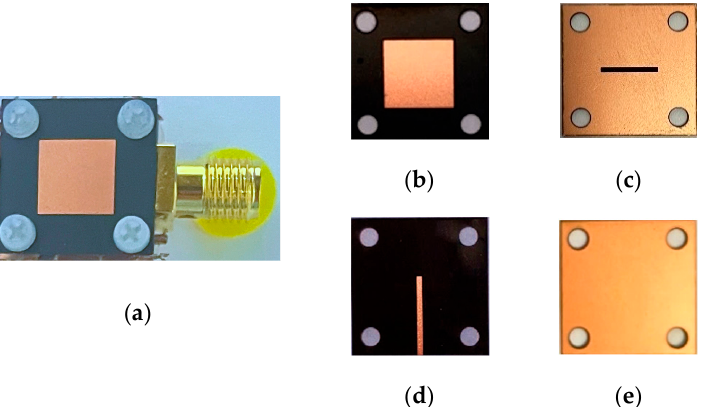
Figure 11. The photograph of the proposed antenna element: ( a ) top view, ( b ) top layer with radiation patch, ( c ) the ground with coupling aperture on top of the middle substrate layer, ( d ) microstrip feeding line on the back of middle layer, and ( e ) metallic reflection surface on the back surface of the lower substrate layer. Table 2. Performance characteristics of the proposed antenna element.